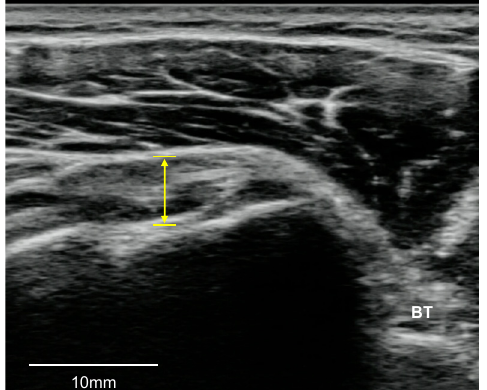
Figure 3. The measurement of the subscapularis tendon thickness. BT, biceps tendon.